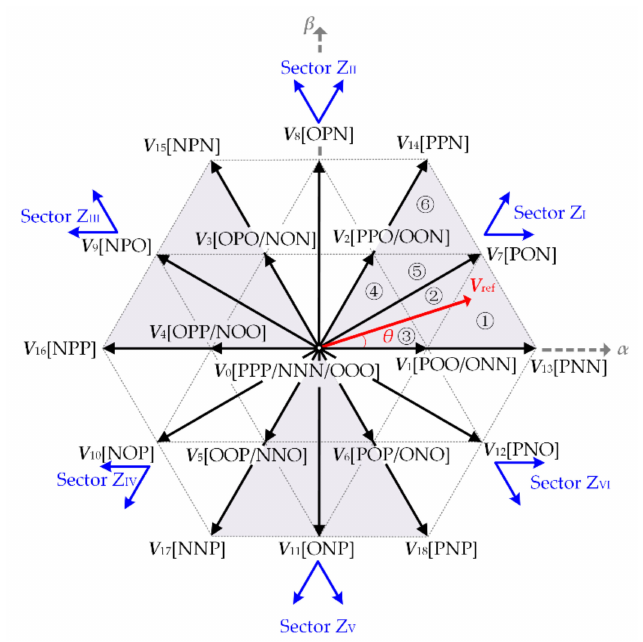
Figure 2. The space vector diagram of the NPC three-level inverter fed three-phase load.